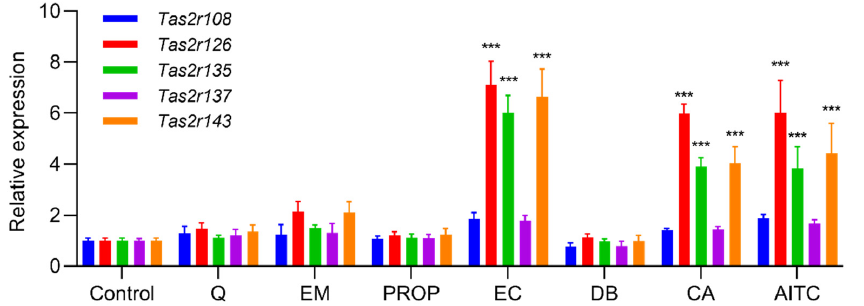
Figure 3. Stimulation by bitter compounds increased the expression of Tas2r genes in 3T3-L1 adipocytes. Mature 3T3-L1 adipocytes were stimulated by quinine (Q, 50 µ M), emetine (EM, 150 µ M), 6-propyl-2-thiouracil (PROP, 5 mM), epicatechin (EC, 2.5 mM), denatonium benzoate (DB, 500 µ M), camphor (CA, 5 mM), or allyl isothiocyanate (AITC 150 µ M) for 1 h. Tas2r expression was determined by RT-qPCR analysis. Actb was used as the reference gene. N = 6, *** p < 0.001 (compound vs. control, Dunnett test).